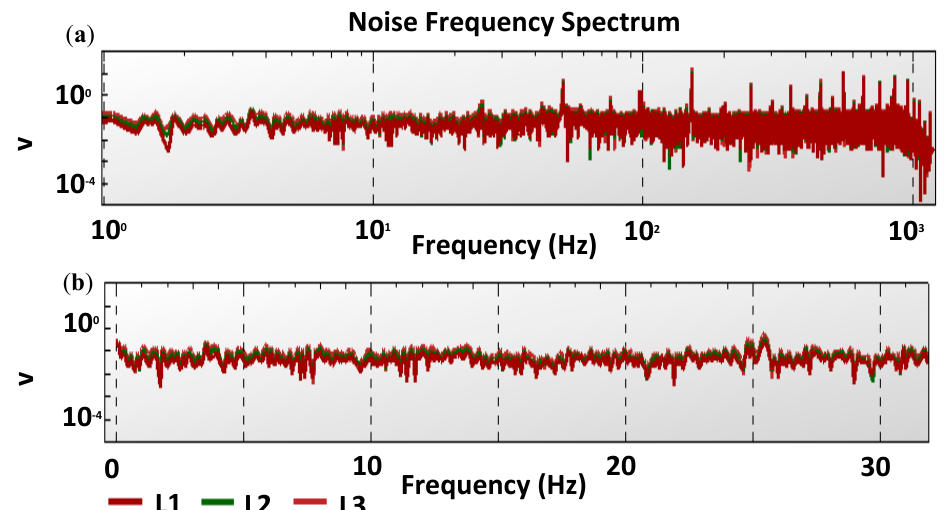
Figure A4. EM telemetry noise characteristics for dipoles L1, L2 and L3: ( a ) frequency spectrum of measured noisy data, and ( b ) frequency spectrum of recorded data for the frequency range of interest.